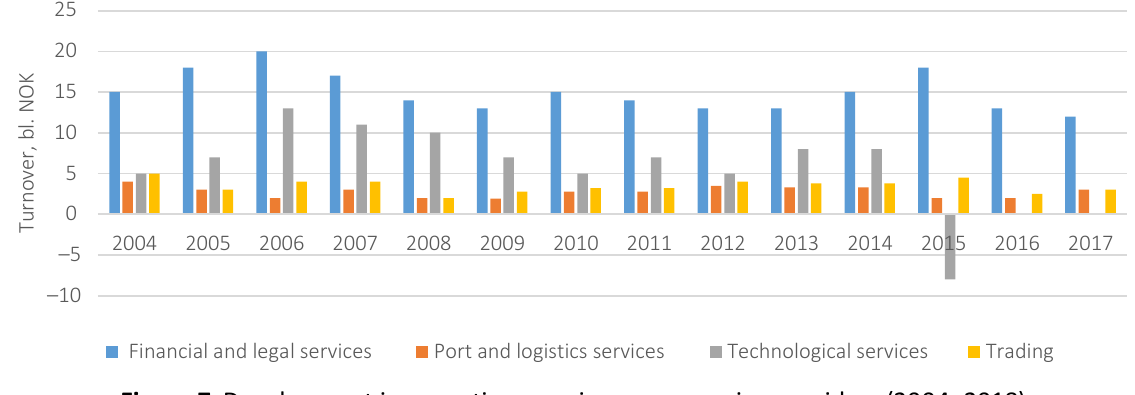
Figure 7. Development in operating margin among service providers